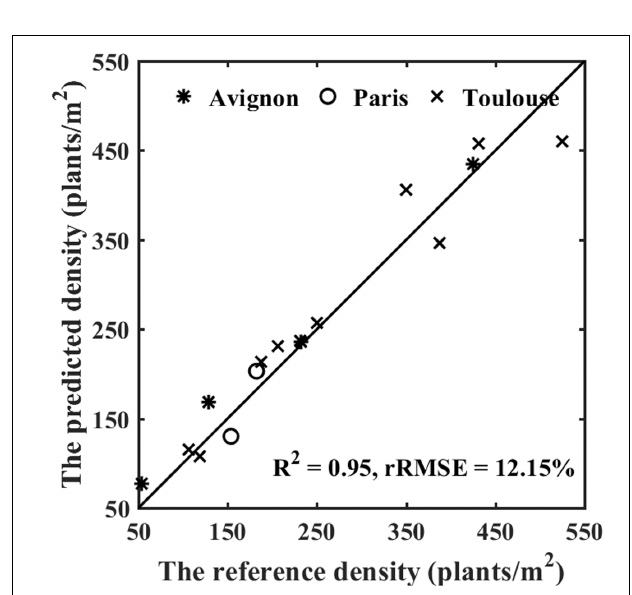
FIGURE 8 | Performance of density estimation over the three